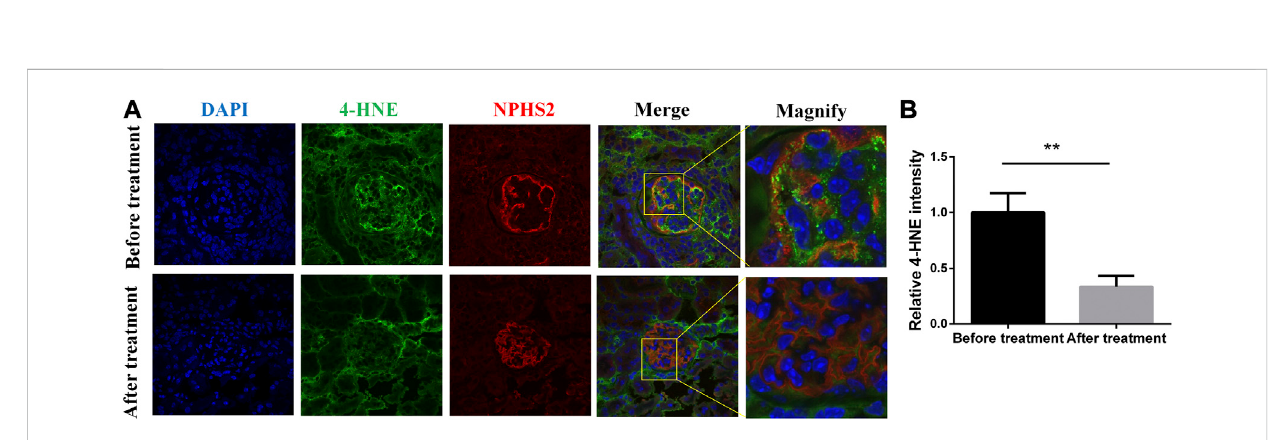
FIGURE 7 Immuno fl uorescent staining of 4-HNE and NPHS2 before and after